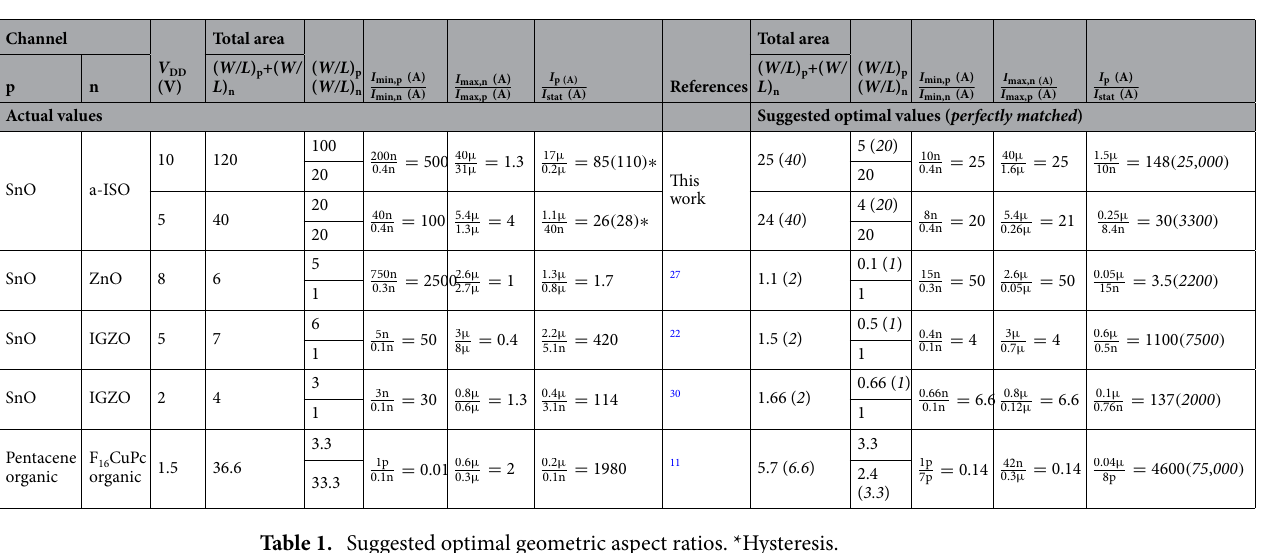
Table 1. Suggested optimal geometric aspect ratios.